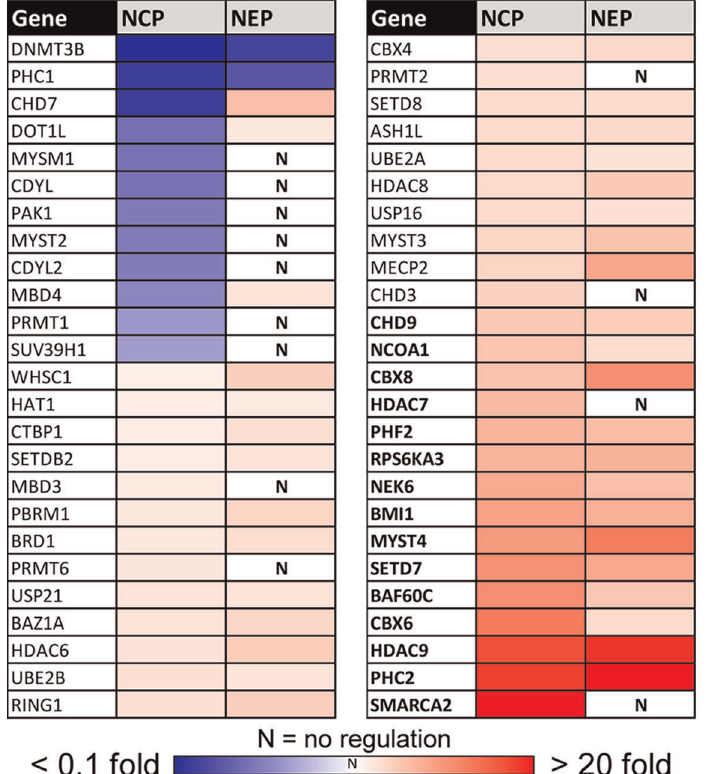
Figure 5. Regulation of epigenetic modifiers in NCP, and their comparison to NEP. The levels of epigenetic regulator gene transcripts were measured in hESC, NCP and NEP by qPCR, and the expression levels were calculated relative to the levels in hESC. All genes that showed significant up- or downregulation in NCP compared to hESC are displayed. The relative expression level (vs. hESC) was color coded, as illustrated in the chromatic scale in the bottom. Genes with . 5-fold expression in NCP vs. hESC are shown in bold. For better comparison, the data for the same genes are shown for NEP in the right-hand column. Measures of variance and p-values are indicated in the supplemental material.